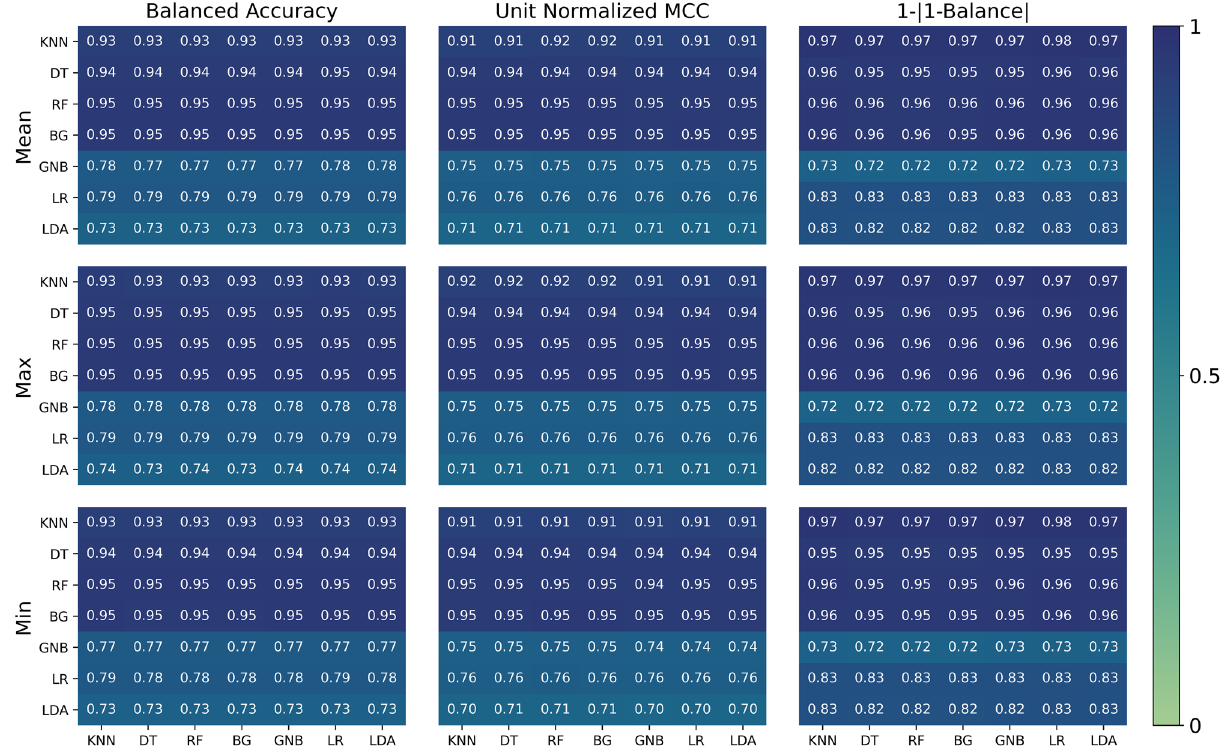
B 1 . On the other hand, the rows | − | −